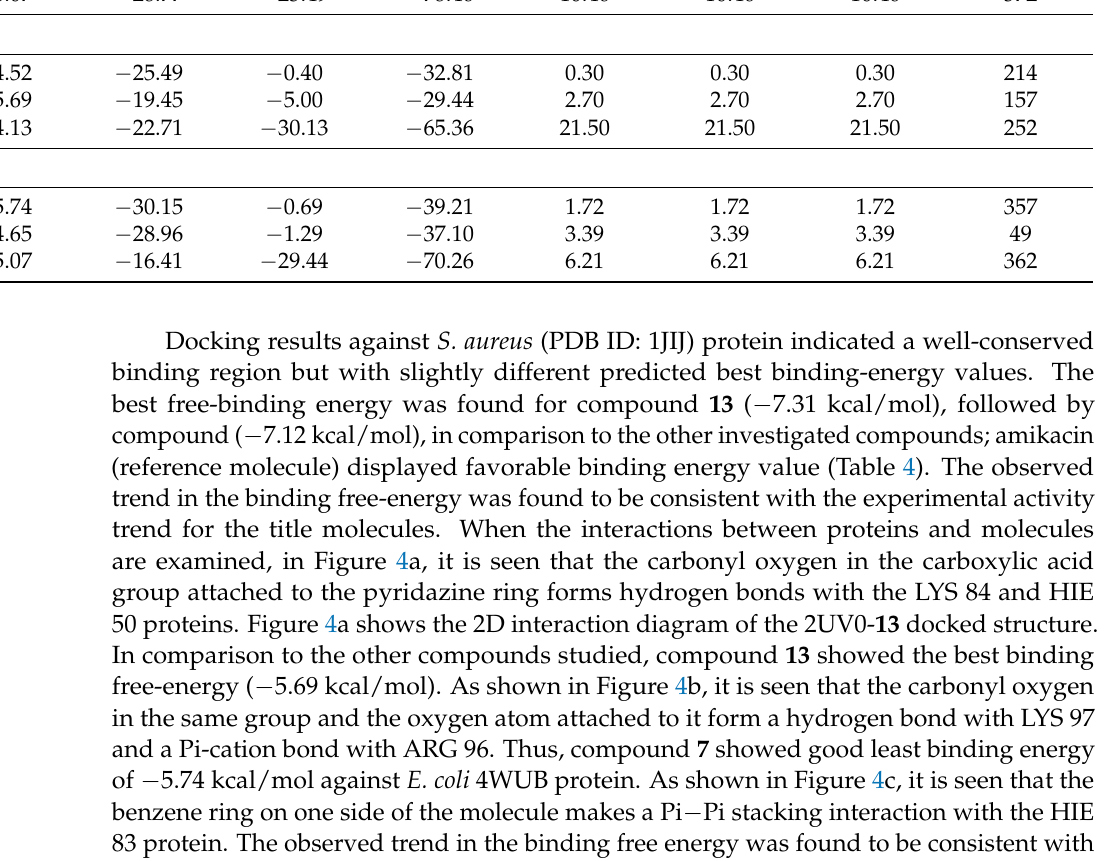
Table 4. Numerical values of the docking parameters of compounds 7 and 13 against enzymes. Compound